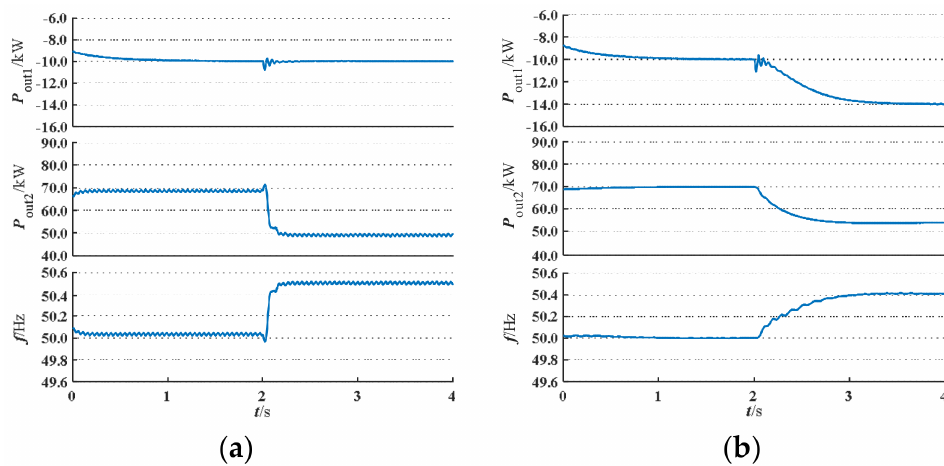
Figure 20. ( a ) Frequency regulation results of traditional PV storage system in the motor mode;